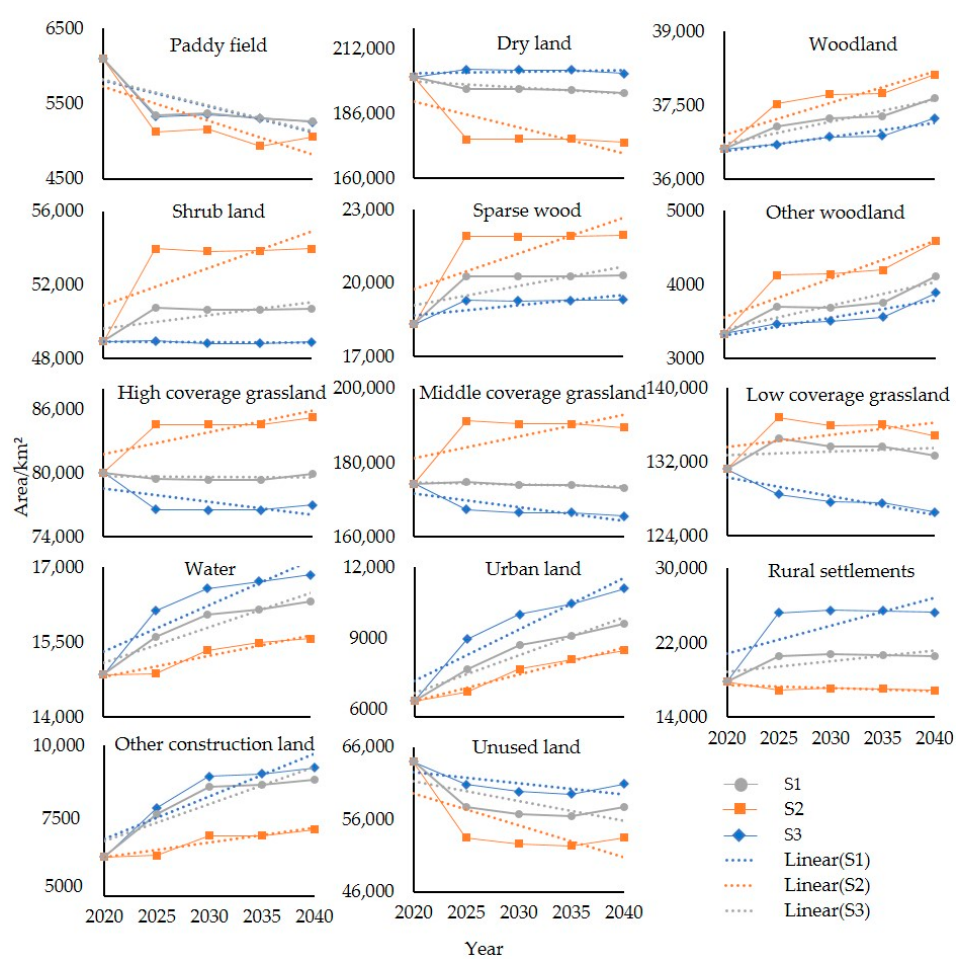
Figure 6. Prediction map of land use in different scenarios in 2025, 2030, 2035, and 2040. Paddy fields and dryland are mainly distributed in the southern plains of the basin and around the river valleys; under S2, they decline significantly (52.1 km 2 /a, 1299.5 km 2 /a). Woodland generally shows an increasing trend, pronounced in S2 (280.28 km 2 /a). The grassland area varies significantly in different contexts. Under S2, grasslands (high-, middle-, and low-coverage grasslands) show an increasing trend. However, under S1 and S3, grasslands show a decreasing trend, with the most significant decrease in S3, with high-, middle-, and low-coverage grasslands decreasing by 0.19, 0.25, and 0.18% per year on average. The water area shows a slow increase, with the most significant increase in S3 (99.70 km 2 /a). Urban land is concentrated in urban clusters in the southern and eastern parts of the study area. Under S3, the area of urban land, rural residential land, and other construction land will continue to grow. However, the growth rate of urban land is sig- nificantly higher than that of rural residential land, with urban land, rural residential land, and other construction land increasing by 67.47, 41.69, and 46.90%, respectively. Under S2, the expansion of urban land in the south and east of the study area is remarkably re- strained; in 2040, urban land expands by only 30%. 3.3. Habitat Quality (2000–2020) 3.3.1. Spatial and Temporal Variation of Habitat Quality The habitat quality index is between 0 and 1, and the larger the value, the better the habitat quality. The study area’s habitat quality table (Table 9) from 2000 to 2020 was ob- tained. The habitat quality of the study area rose first and then declined. Specifically, it